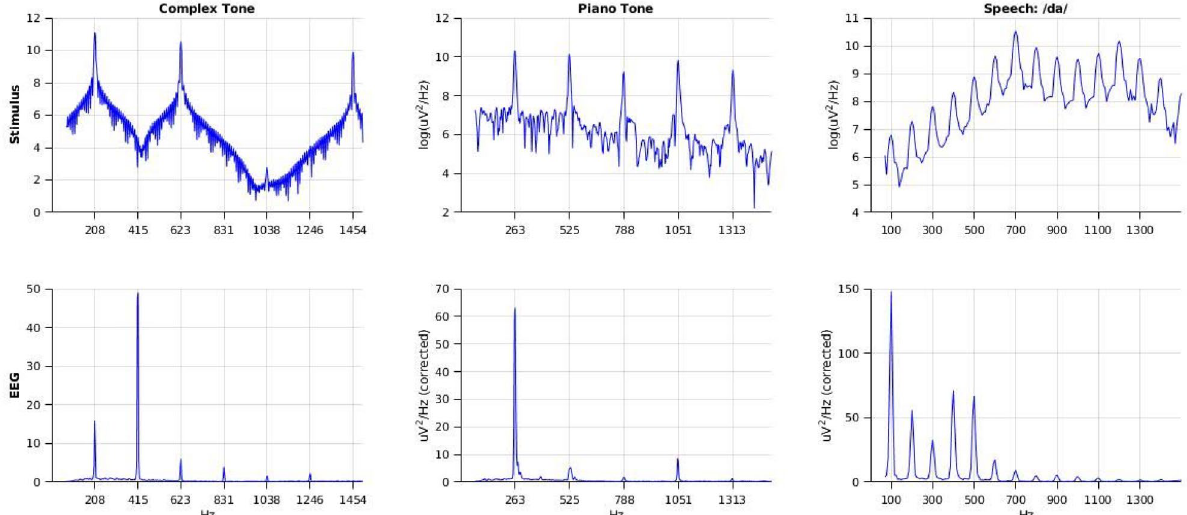
Figure 2. Power Spectra of Stimuli and of Frequency-Following Responses. The nearest integer frequency to the harmonics of the stimulus is marked on each plot, except for the speech stimulus, in which every other harmonic is marked to avoid visual clutter. The EEG spectra are corrected for 1/f frequency drop-off here for visualization, but uncorrected values were used for analysis.